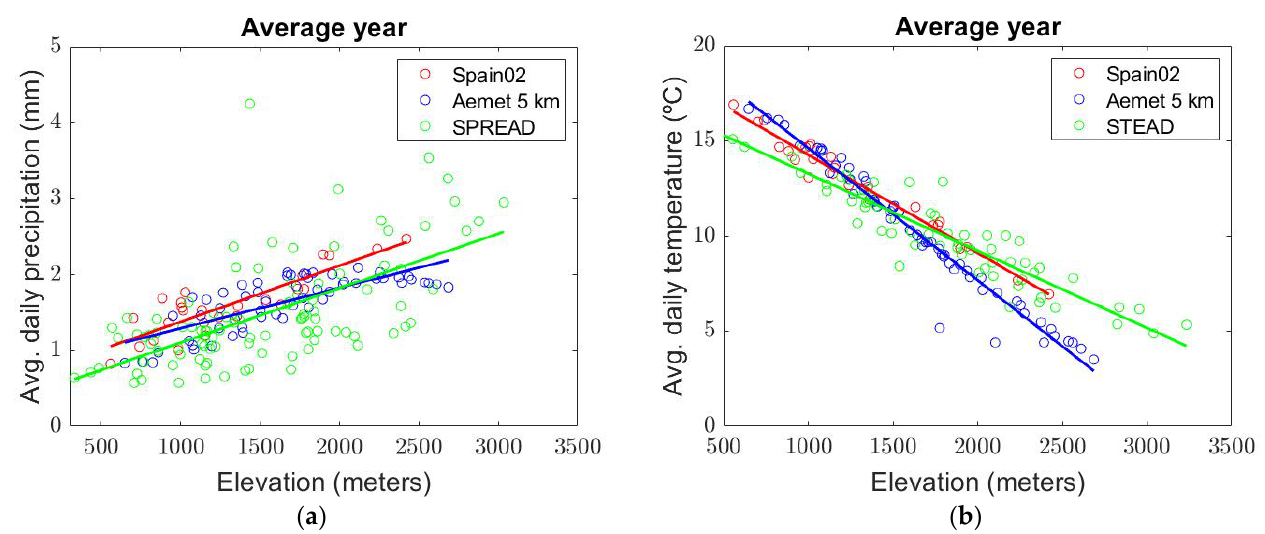
Figure 2. Daily average variation with elevation for the different databases for ( a ) precipitation; ( b ) temperature